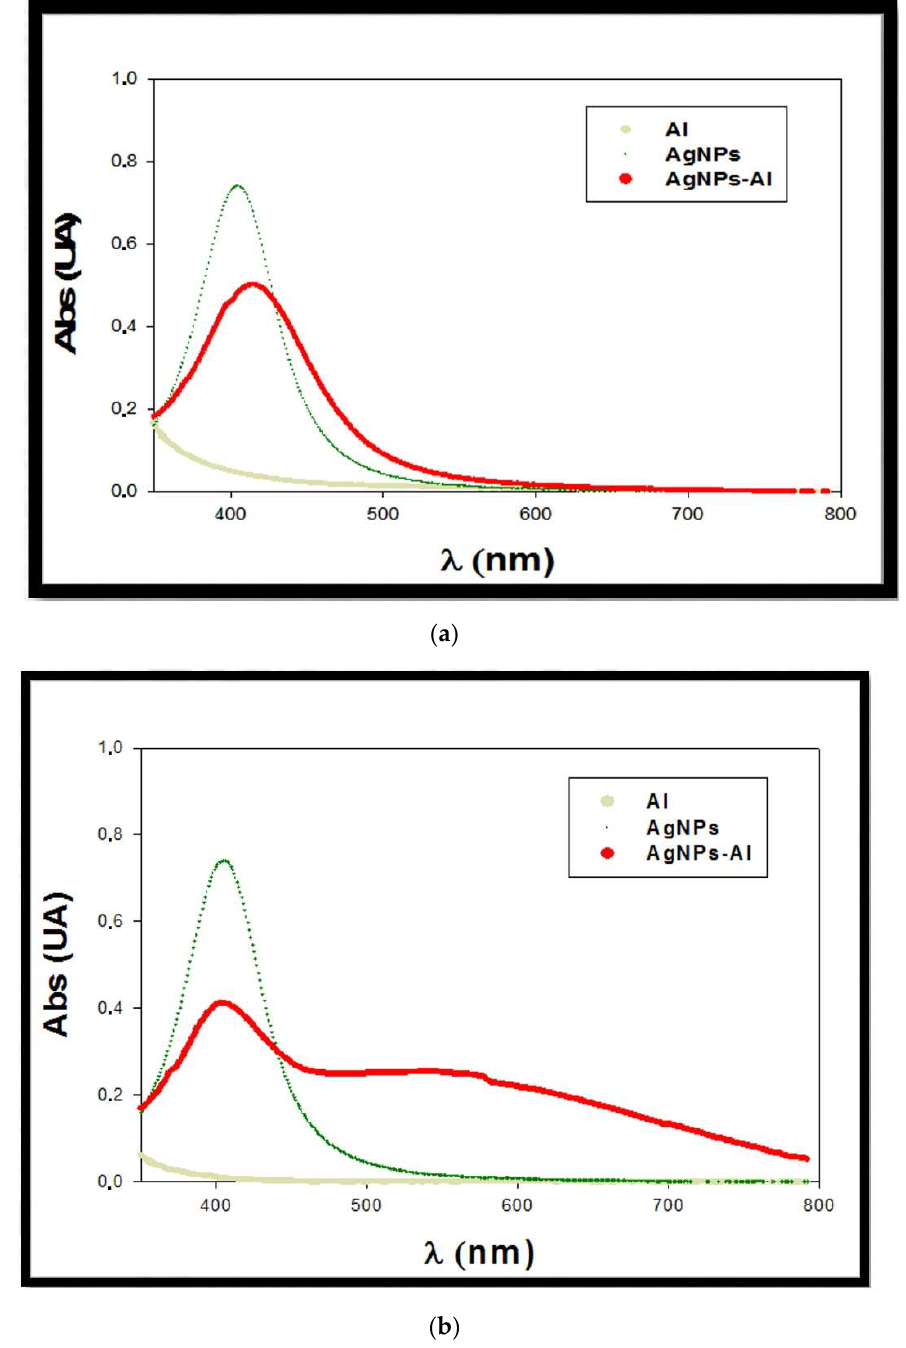
Figure 3. Influence of pH in the interaction of citrate+PVP-AgNPs:Al. ( a ) pH 3 and ( b ) pH 2. C Al(III) = 100 mM; C Citrate+PVP-AgNPs = 7.6 × 10 −15 M.